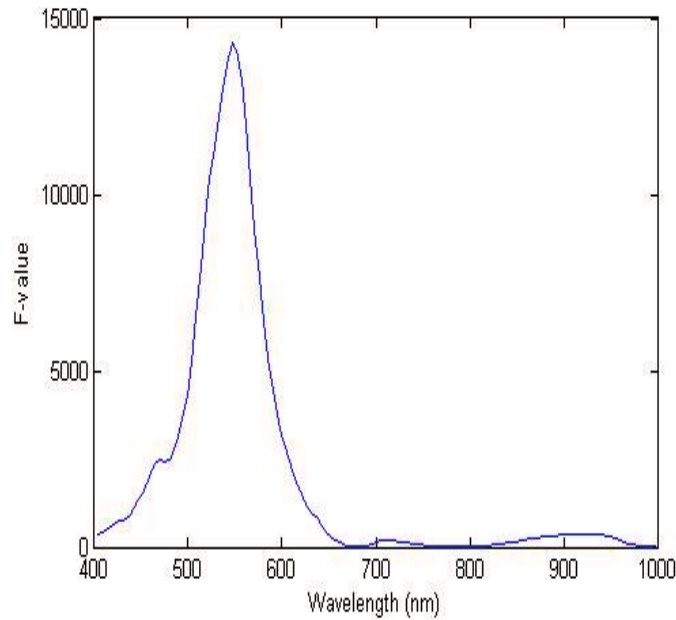
Figure 5. One-way ANOVA results for classifying sound and discolored areas of lettuce using the single waveband algorithm in the wavelength range from 400 to 1000